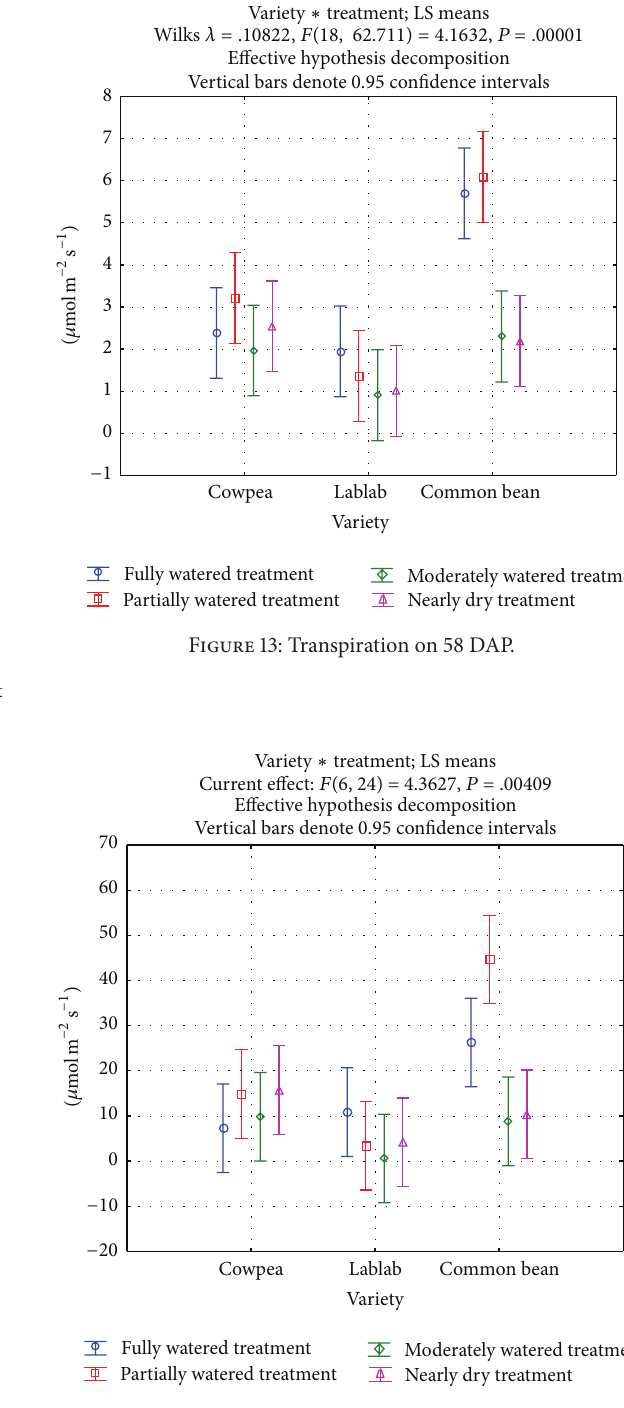
Figure 14: Photosynthesis on 55 DAP.